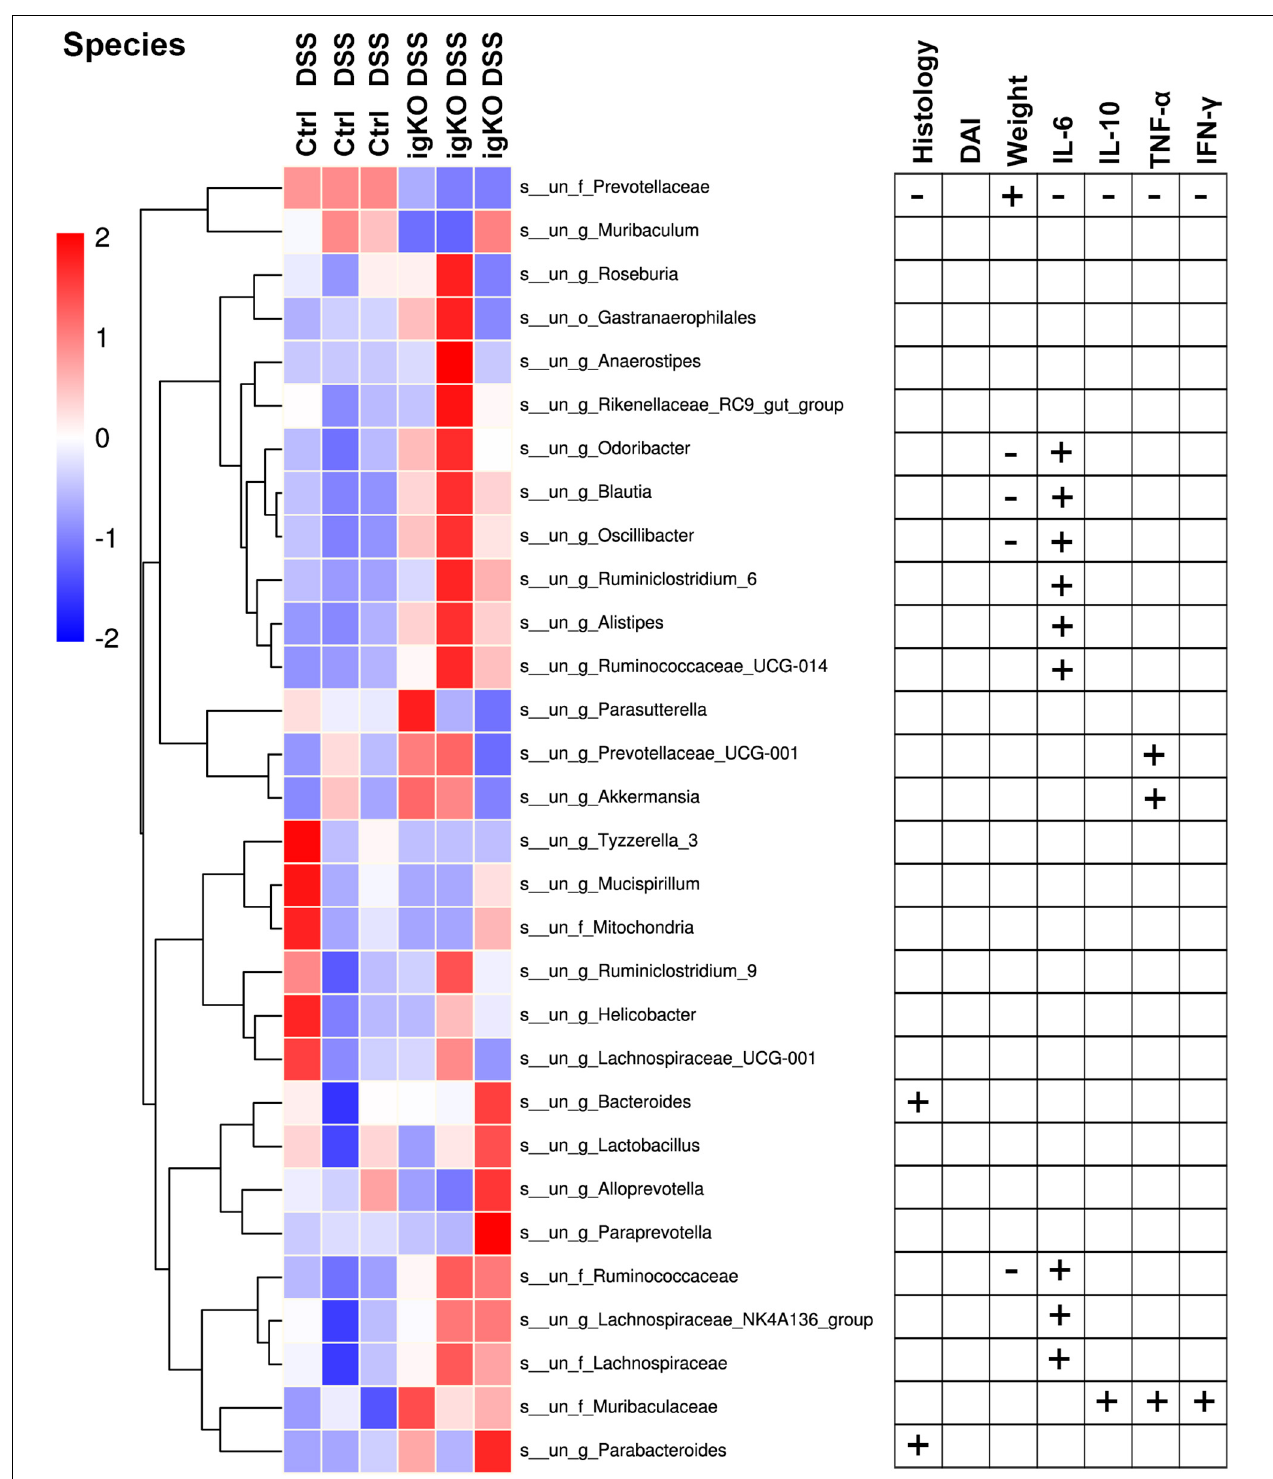
FIGURE 3 | Correlation analysis of bacterium abundance and colitis-associated characteristics. The heatmap of the alterations in gut microbiota between Rgmb-deficient and control mice with colitis (left panel). Statistical analyses on the correlations between differential bacteria and inflammation in Rgmb-deficient mice with colitis (right panel). Each fresh fecal sample was pooled from five littermate mice. + Positive correlation with statistical significance. - Negative correlation with statistical significance.